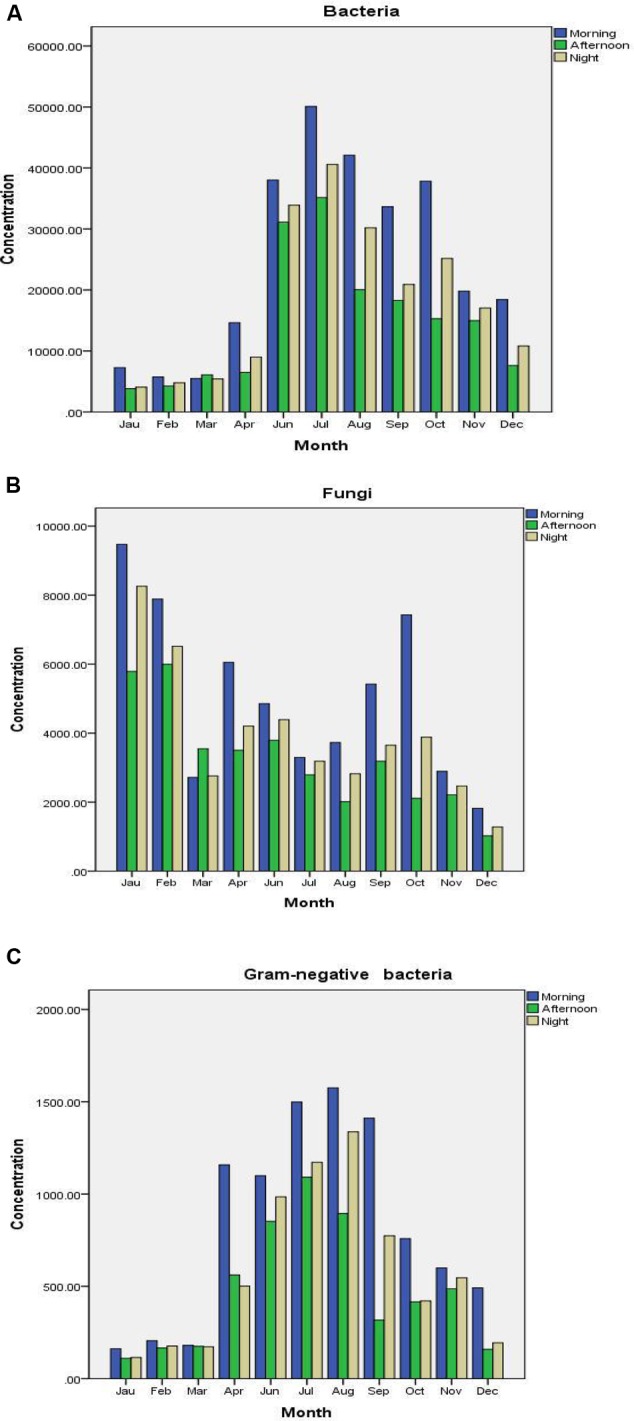
Daily concentration variations of bacteria (A), fungi (B), and Gram-negative bacteria (C).